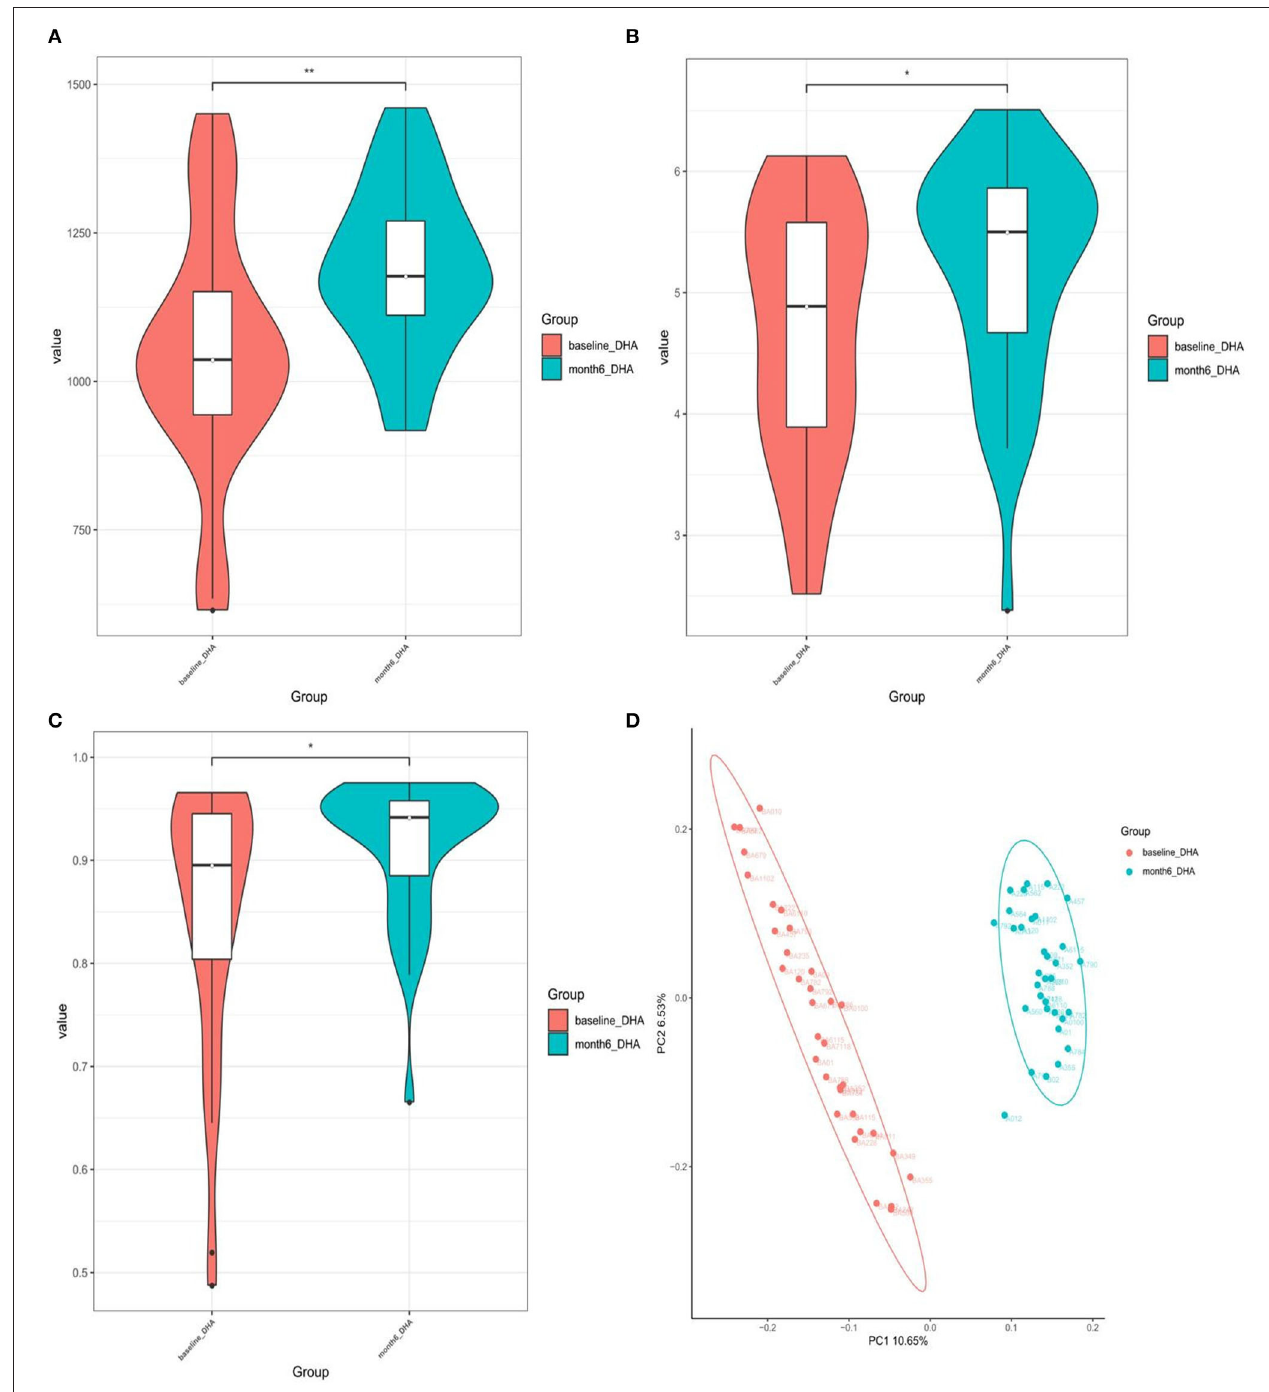
GABA, and DL-histidinol] and three were increased [PI (20:0/22:4(7Z,10Z,13Z,16Z), PS (17:2(9Z,12Z)/22:1(11Z), and pregnenolone] ( Figure 6A